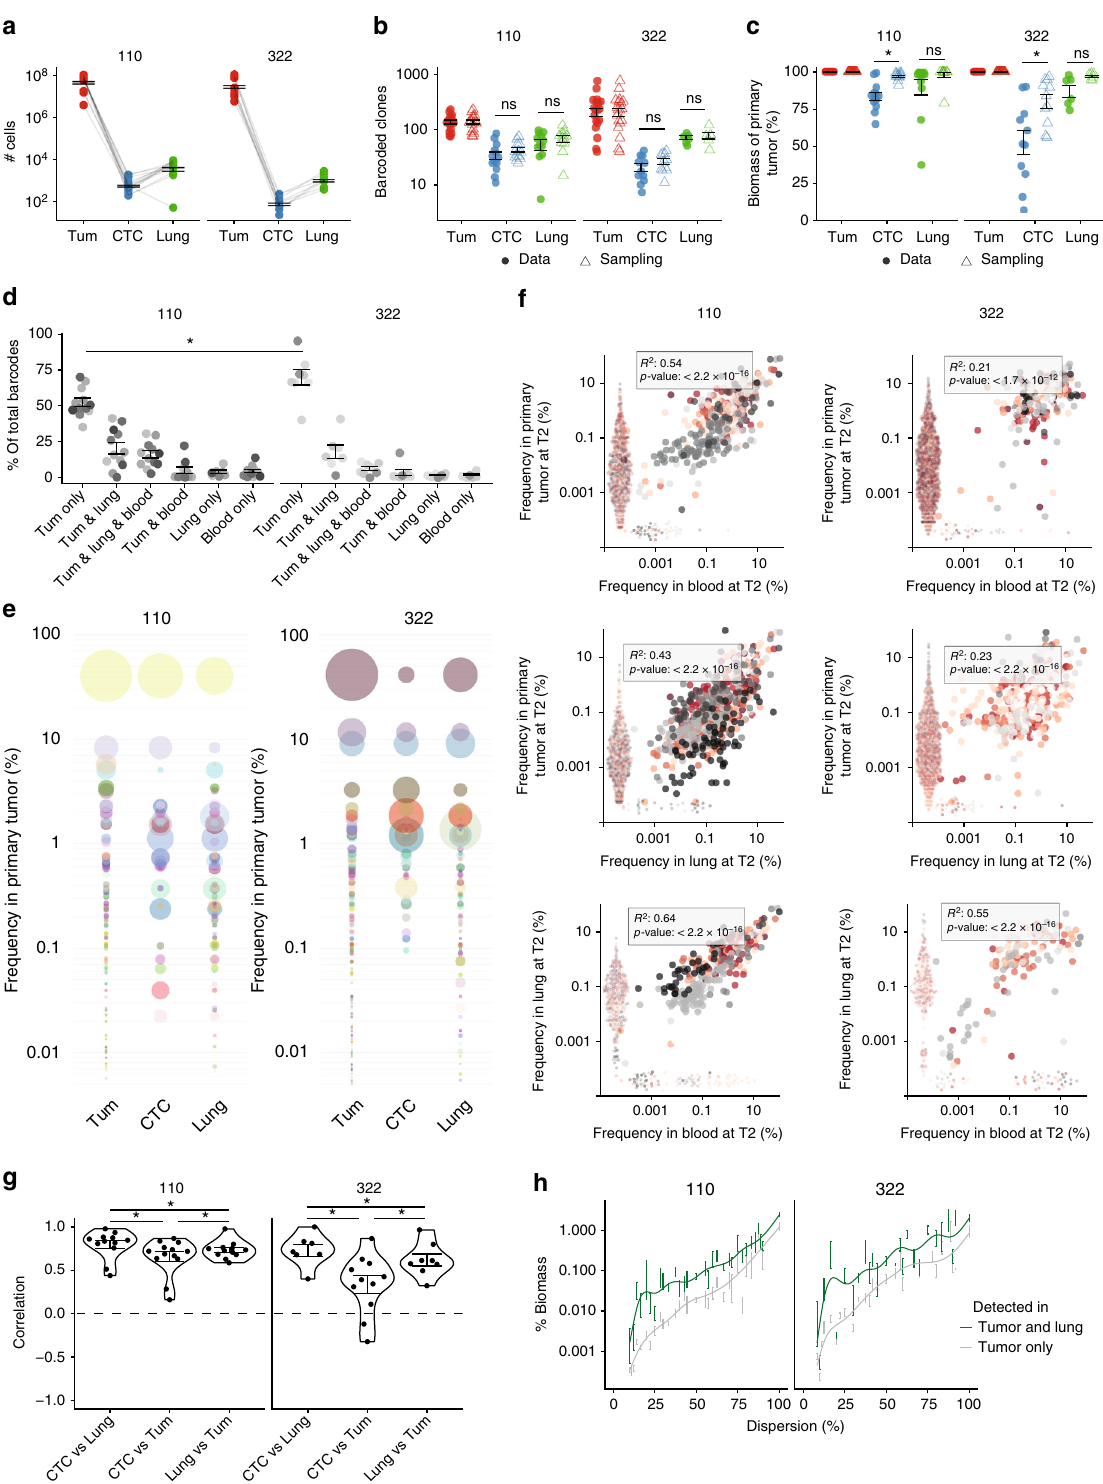
To better understand the dependency between the volume of blood that is analyzed and the number of detected barcodes, we split the terminal blood sample into 10 smaller (~80 µl) samples and assessed barcode diversity in each one. By incorporating fewer and fewer samples in the analysis we observed a clear drop in detected barcodes (Supplementary Figure 3C), but a less marked change in representative biomass (Supplementary Figure 3D), indicating that some clones are not detectable